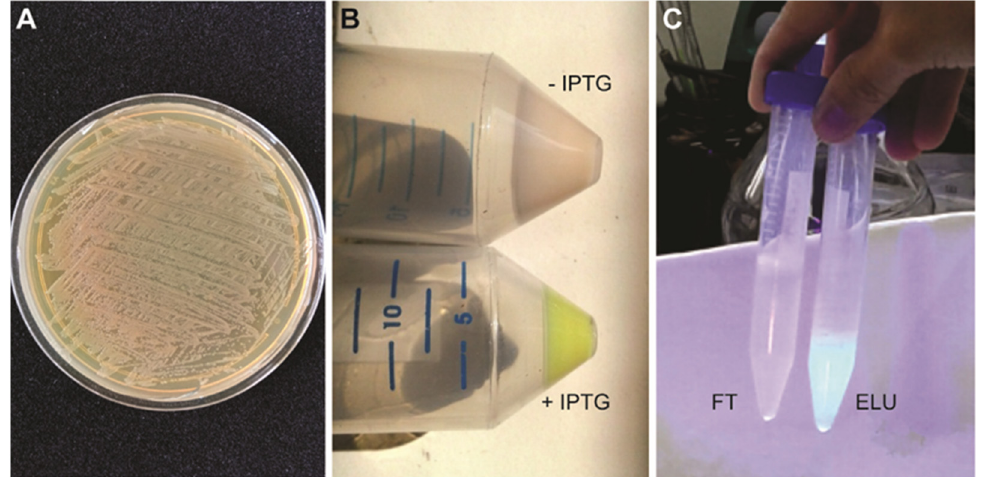
Figure 2. ( A ) Starting bacterial plate. ( B ) Greenish pellet obtained after induction with IPTG. ( C ) GFP fluorescence under UV light of different fractions during IMAC. FT: IMAC flow through; ELU: IMAC elution.